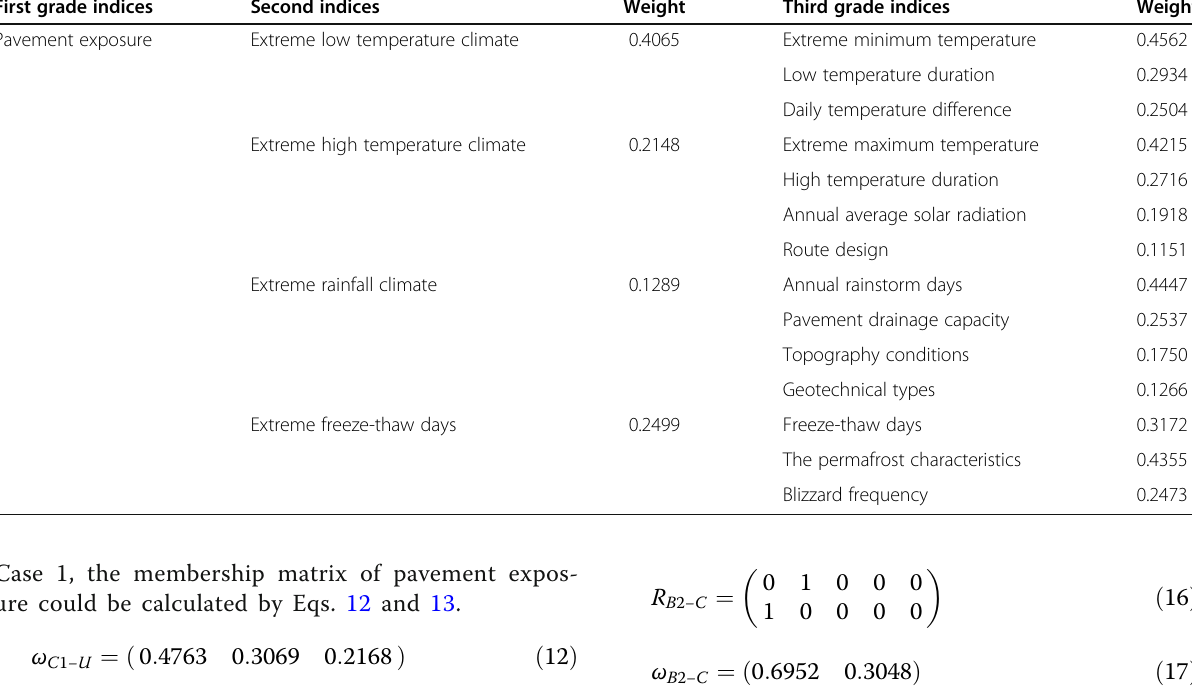
Table 10 Weight of pavement exposure indices